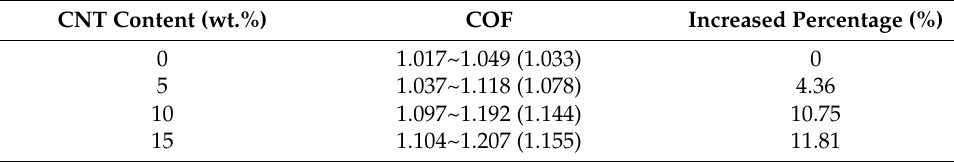
Table 2. COF details of different CNT contents CNT/VNR